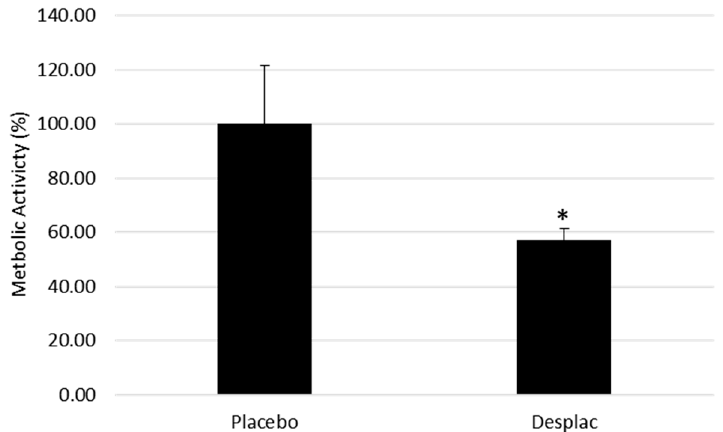
Figure 1. Mean and standard deviation of the mean of the metabolic activity of biofilms treated with the different agents. * A statistically significant difference using ANOVA, followed by Tukey’s test ( p ≤ 0.05).